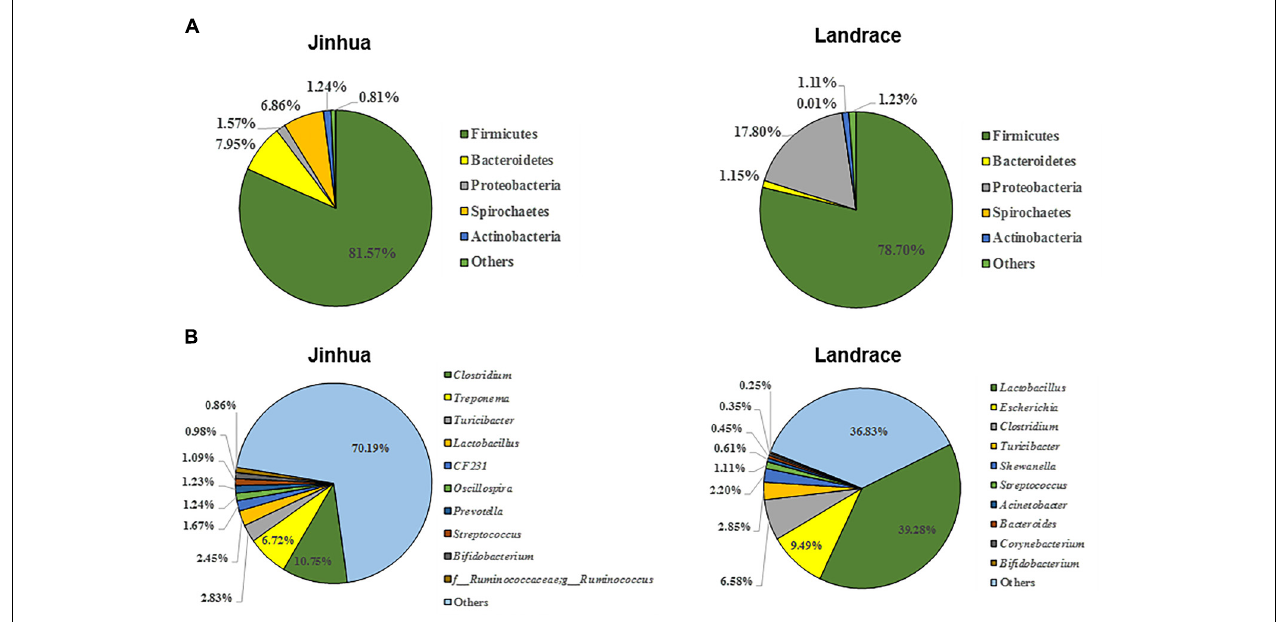
FIGURE 4 | The composition of the fecal bacterial community in Jinhua and Landrace donor pigs at the phylum (A) and genus (B) levels. Only top 5 phyla and top 10 genera are shown.